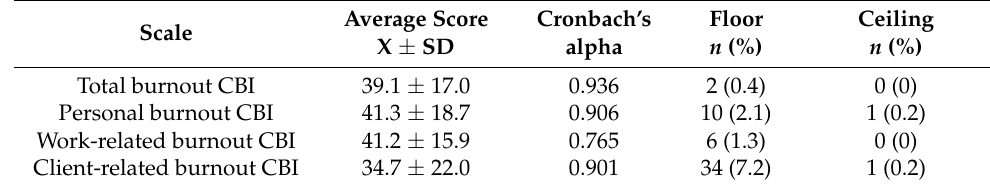
Table 1. Mean scores on the CBI scale and Cronbach’s